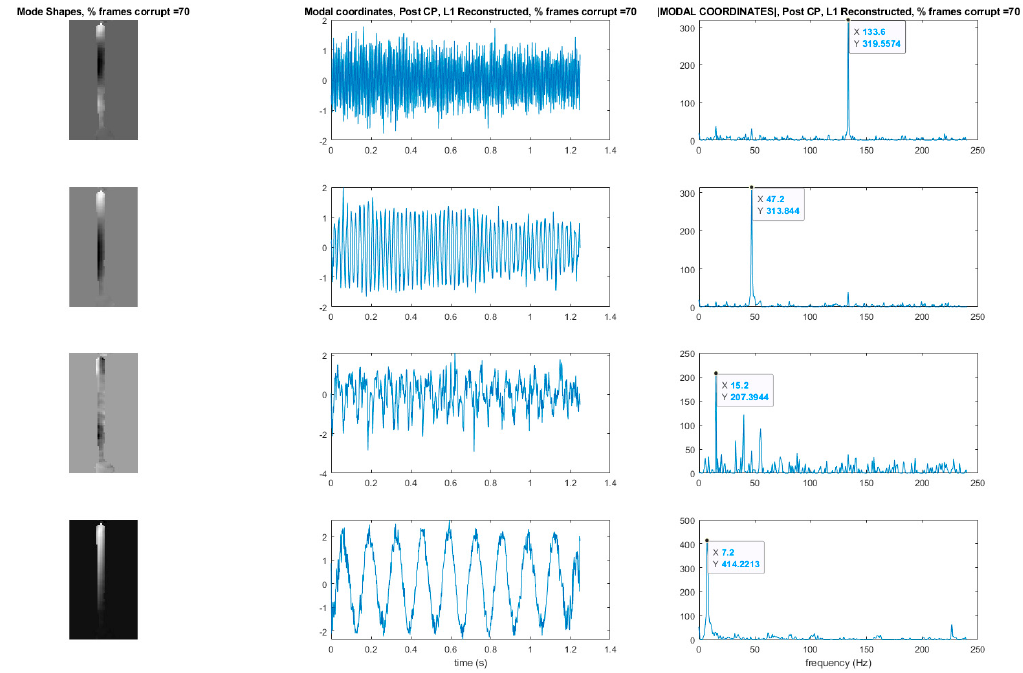
Figure 23. Mode shapes recovered from randomly sampled video without the of L1 minimization. Modal coordinates are recovered using L1 minimization on the output of the complexity pursuit algorithm. Y -axis of the modal coordinate and the magnitude of the fft(modal coordinate) plots are arbitrarily scaled displacement.